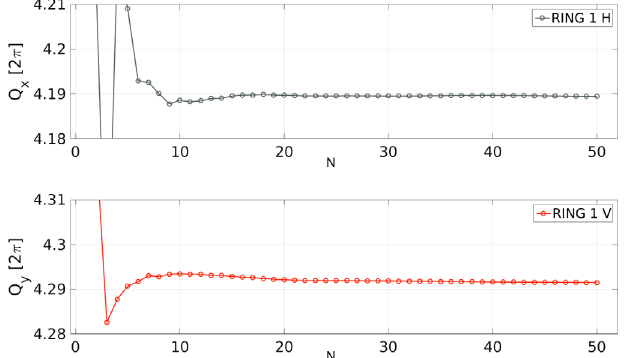
FIG. 17. Tune measurements with respect to the number of turns N at the PSB ring 1 by using horizontal (top) and vertical (bottom) data.